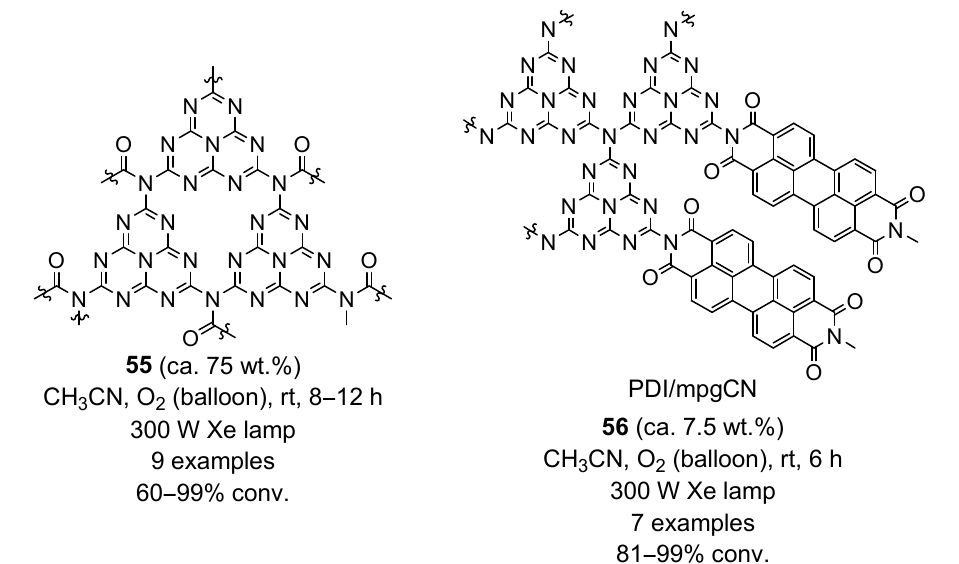
Figure 12. Results obtained in the aerobic photo-oxidative coupling of benzylamines to N -benzylidene benzylamines 2 catalyzed by 55 and 56 .